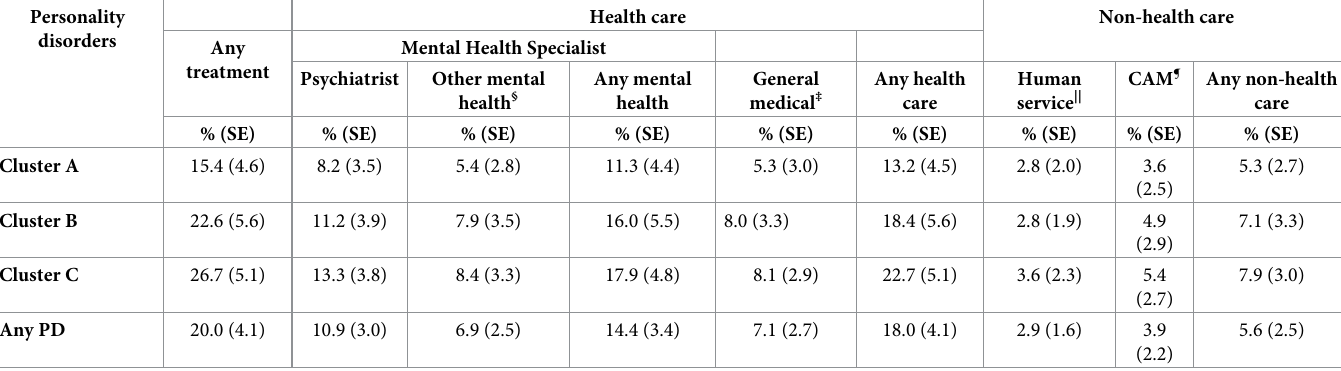
Table 7. Prevalence of 12-month treatment among those with personality disorders in the Sao Paulo Metropolitan Area. Personality